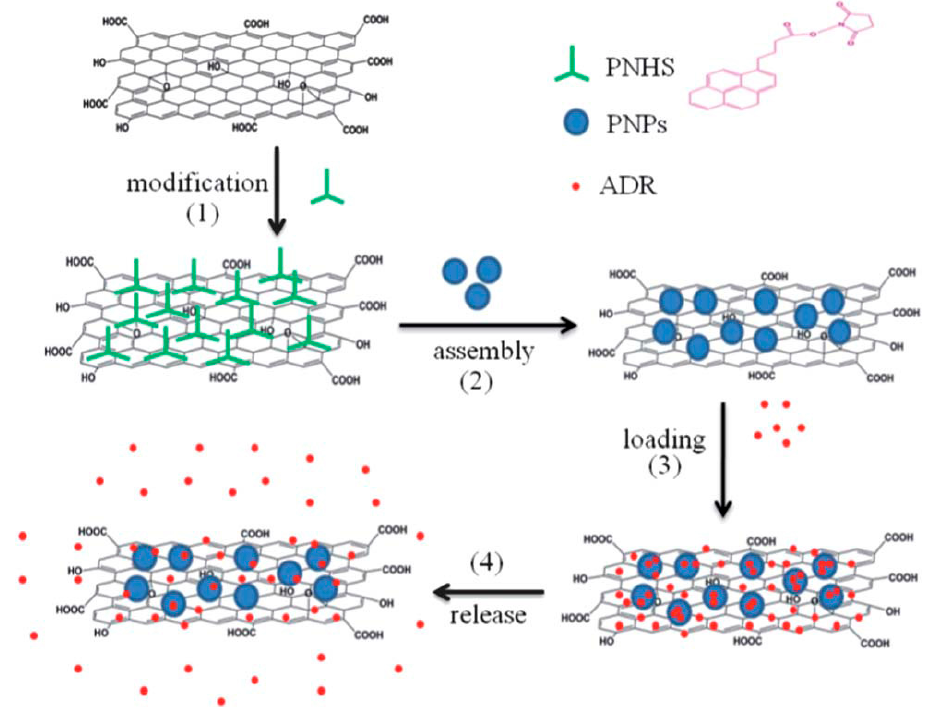
Figure 7. Schematic illustration of the synthesis of thermo-responsive graphene (GO)-polymer nanoparticles (PNPs) nanohybrids for loading and release of adriamycin (ADR). Reproduced with permission from [35]. Copyright Royal Society of Chemistry, 2014.